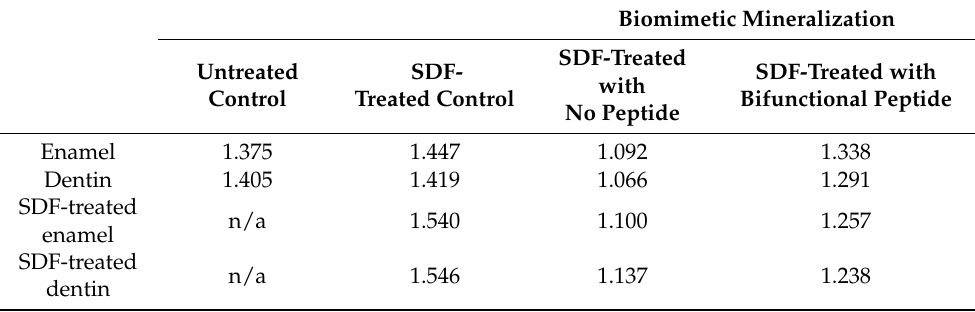
Table 2. Averaged calculated Ca/P ratios of dental tissues in untreated and SDF-treated regions in dentin and enamel